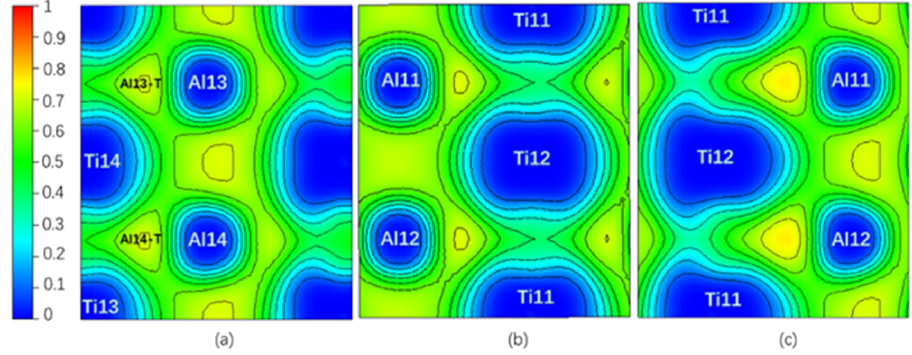
Figure 6. (Color on line.) ( a ) ELF on Layer7 under 0.18 shearing displacement, ( b ) ELF on Layer6 under 0 shearing displacement, and ( c ) ELF on Layer6 under 0.36 shearing displacement in a pure twin γ-TiAl.